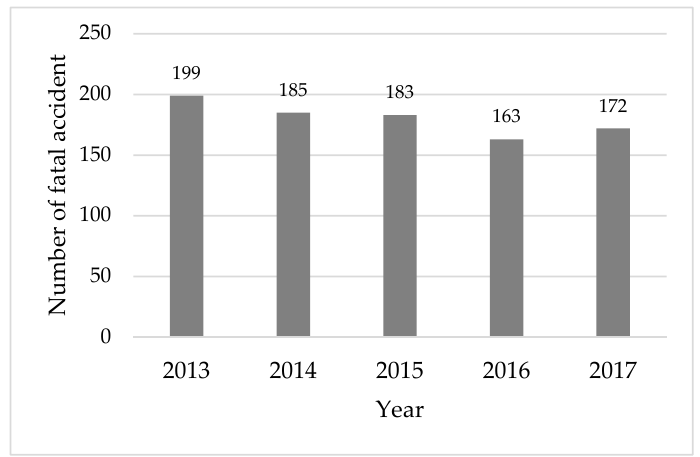
Figure 10. Situation of fatal accidents in Romania during 2013–2017 [2]. Safety 2019 , 5 , x